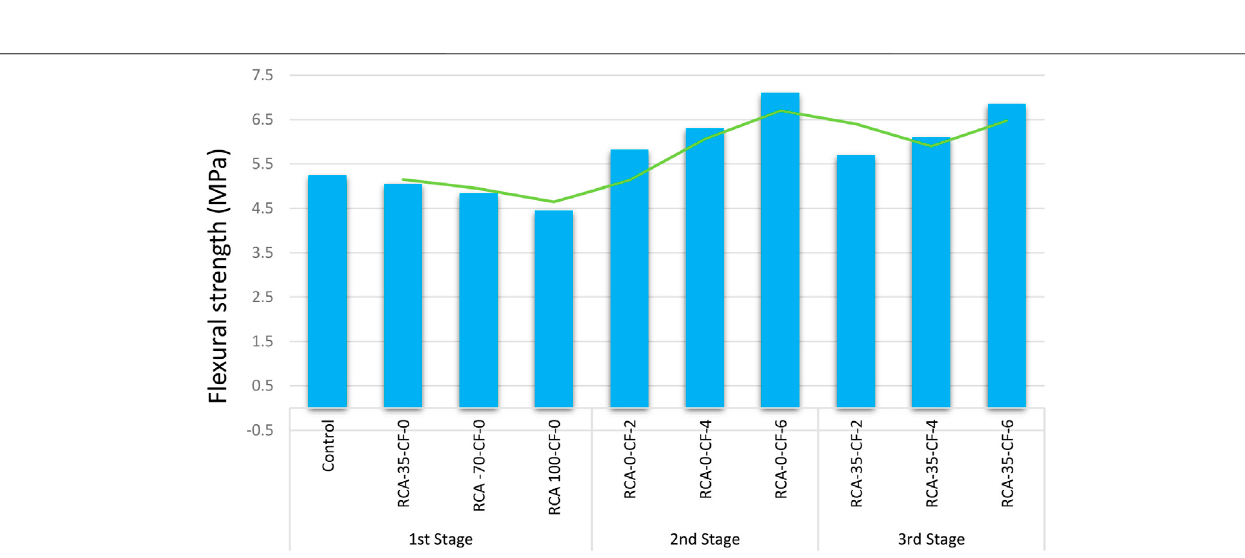
Frontiers in Materials |